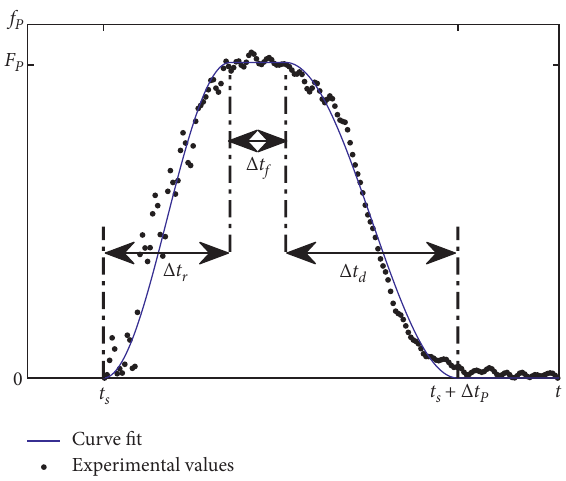
Figure 1: The mathematical model of the